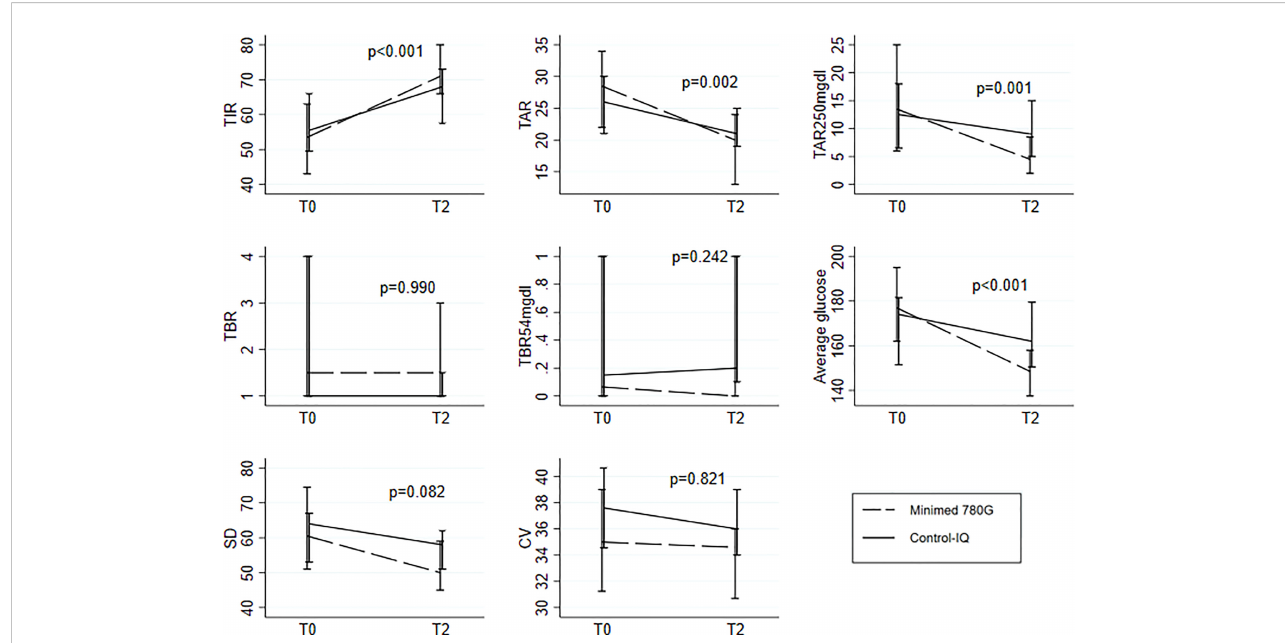
FIGURE 2 Median(IQR) at To and T2 for the 8 parameters under study separately for the two systems; comparison of the pattern change between the two groups testing the Time-Group interaction in the linear mixed models with random intercept. All the models were adjusted for the following baseline variables: age, disease duration, HbA1c and type of previous